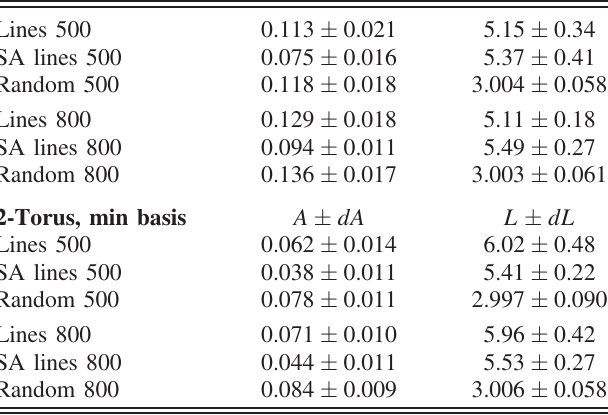
TABLE I. Mean and variance of A and L of the point clouds in Figs. 12 and 13.